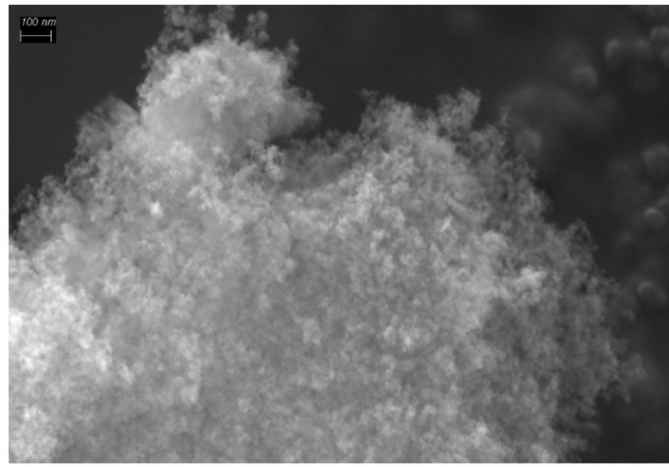
Figure 5. Scanning electron micrograph (SEM) of